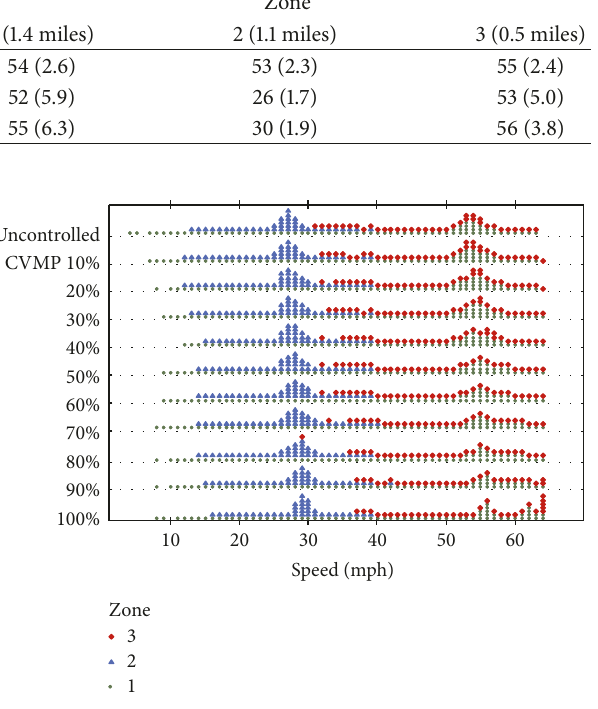
Figure 10: Comparison of speed distributions under different C/AV market penetration rates. Each symbol represents up to 582